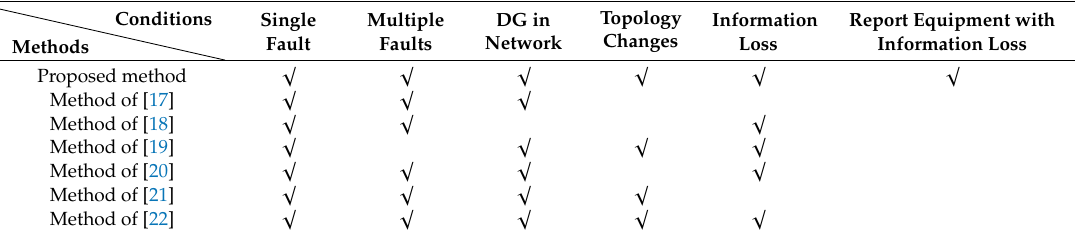
Table 10. Comparison with other fault location